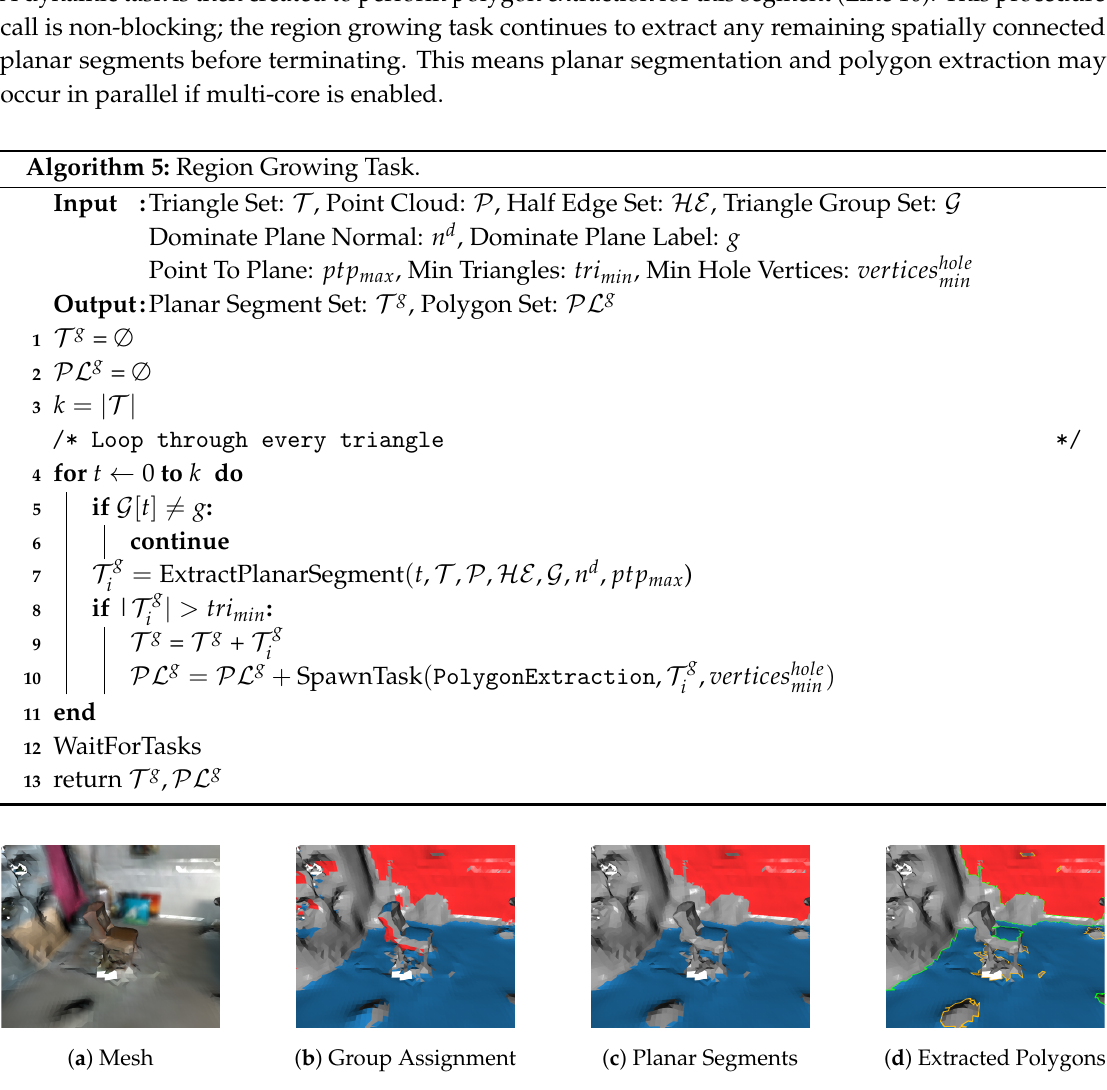
Figure 13. ( a ) An example mesh to demonstrate planar segmentation and polygon extraction using two dominant plane normals, represented by the floor and wall; ( b ) Every triangle is inspected for filtering and clustered through group assignment. Blue and red triangles meet triangle edge length constraints and are within an angular tolerance of the floor and wall surface normals, respectively; ( c ) Region growing is performed in parallel for the blue and red triangles. The top chair surface and floor are distinct planar segments; ( d ) Polygonal representations for each planar segment are shown. The green line represents the concave hull; the orange line depicts any interior holes. Note that small segments and small interior holes are